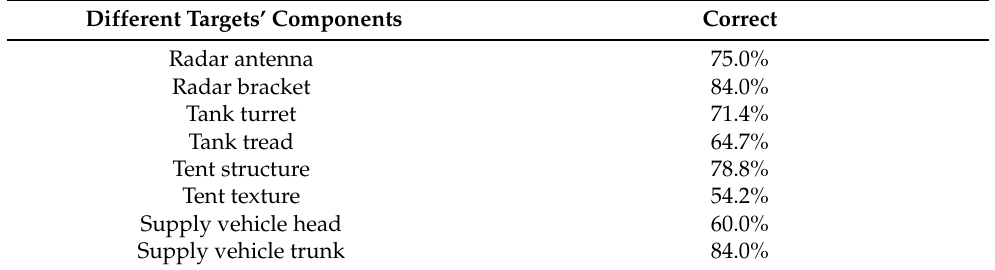
Table 6. The results of the assessment of damaged components based on convolutional feature